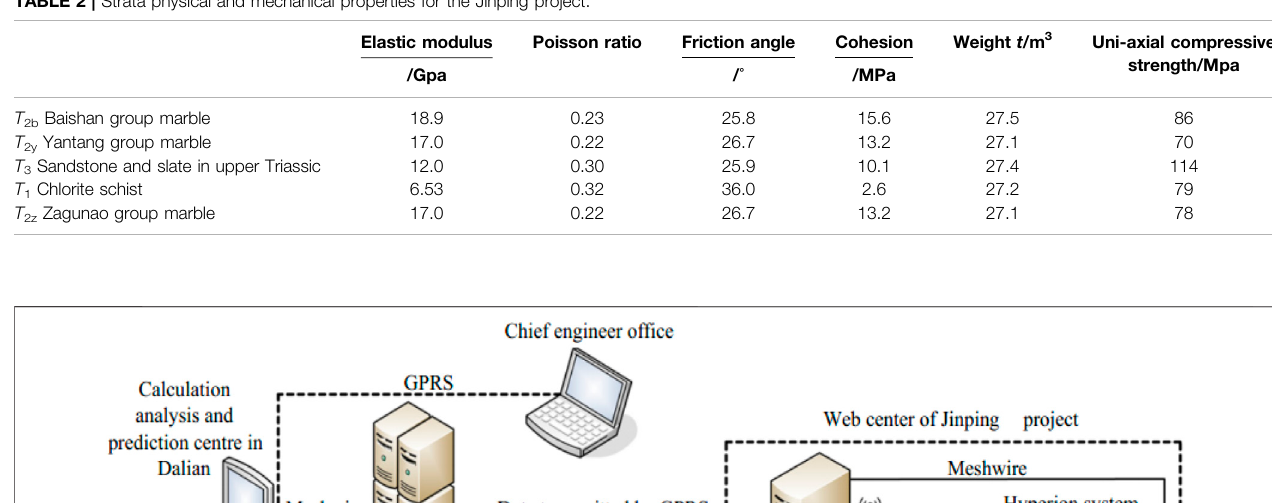
Frontiers in Earth Science |